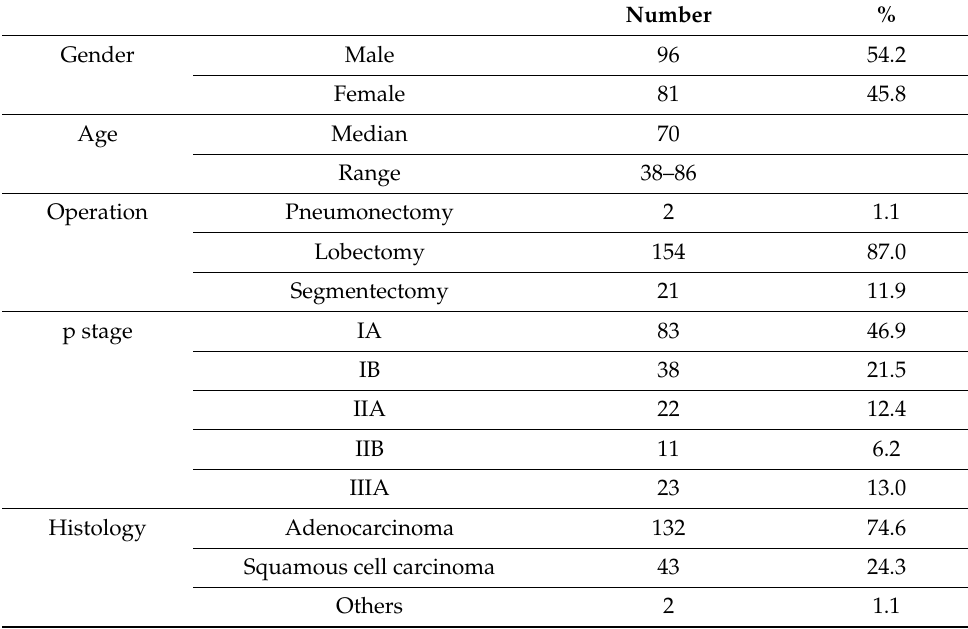
Table 1. Clinicopathological factors in the lung cancer patients.